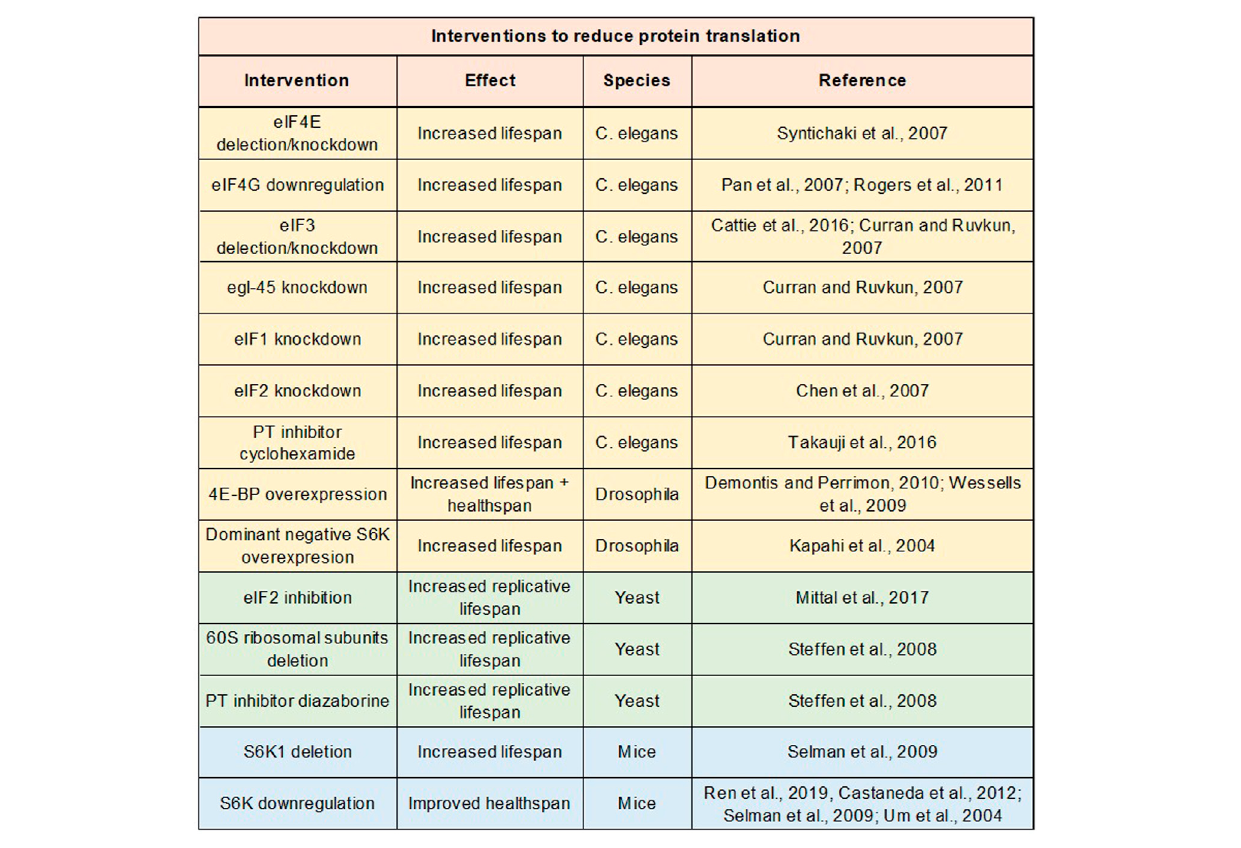
Frontiers in Cell and Developmental